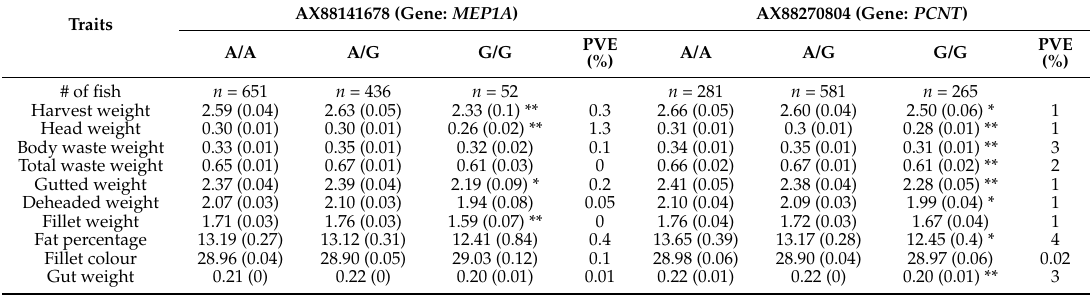
Table 2. Results of the association analysis including the predicted mean value (and standard error) and proportion of additive genetic variance due to SNP (PVE) for each trait and genotype class. AX88141678 (Gene: MEP1A Traits